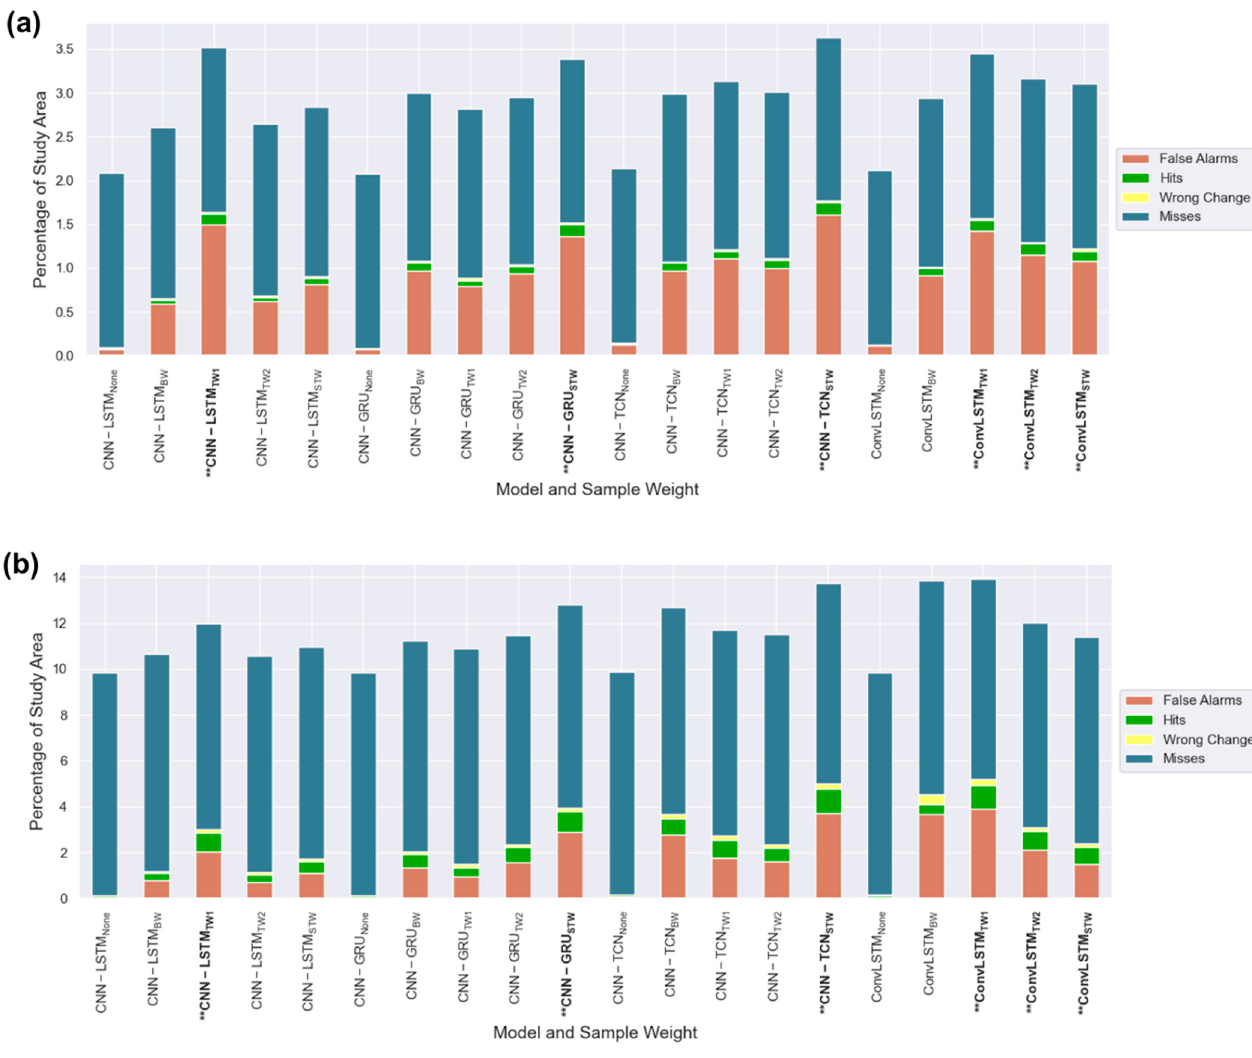
Figure 6. Components of agreement and disagreement as a percentage of the study area for ( a ) the 2016 forecast and ( b ) the 2020 forecast. The model and sample weight combinations with the top six FOM values (Figure 4) are denoted with the prefix **.